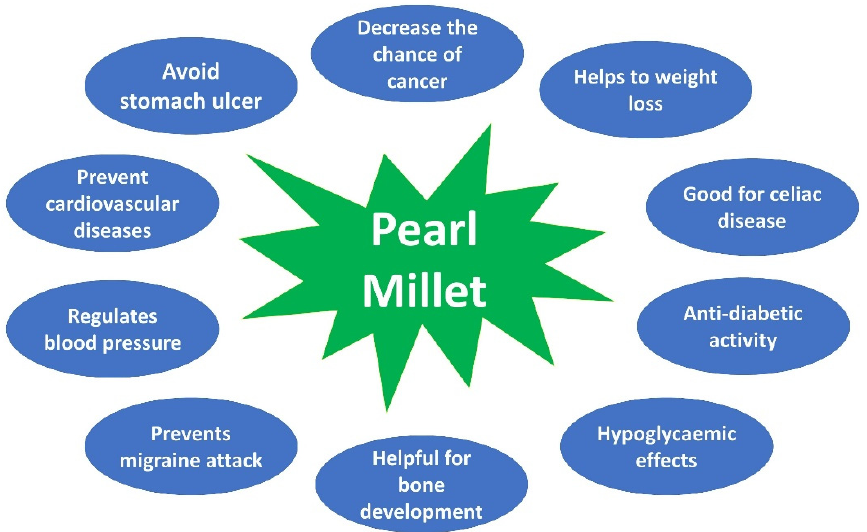
Figure 3. General Biomedical Application of Pearl Millet.